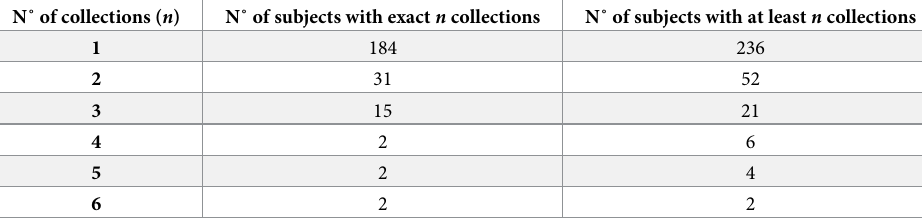
Table 2. Number of subjects with exactly and at least n observations collected.